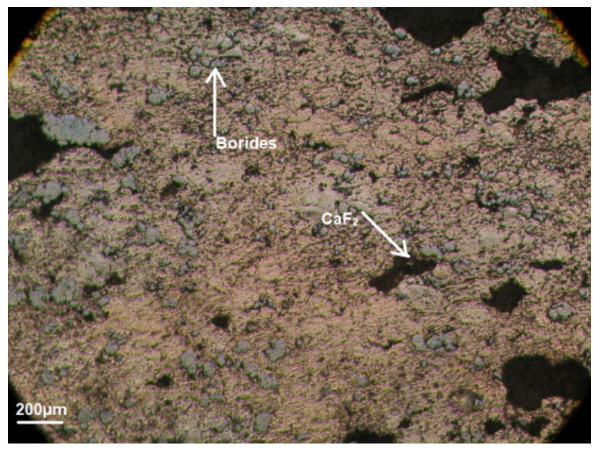
Figure 6. Structure of the Ni + (18–45)%(MoB 2 + ZrB 2 ) + 5% (CaF 2 or BaF 2 ) composite material.